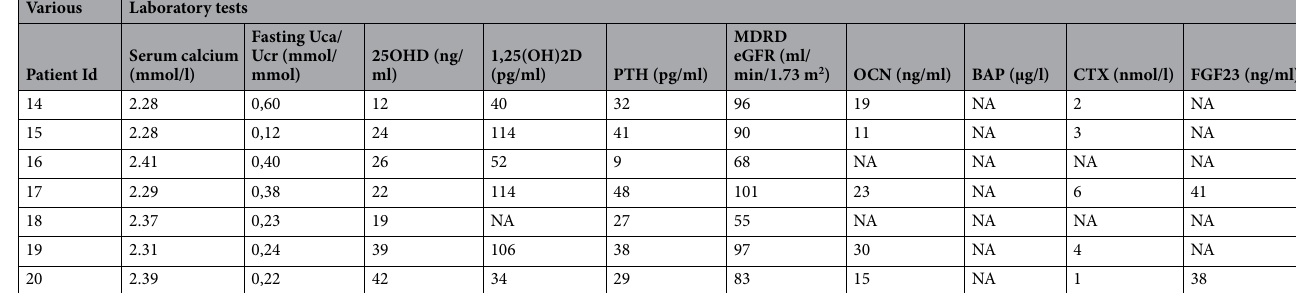
Table 1. Phenotypic characteristics of patients with SLC34A3 variants. a Unlike the other patients, the lowering of the TmPO4/GFR was inconsistent. TmPO4/GFR ratio of maximum rate of renal tubular reabsorption of phosphate to glomerular filtration rate, TRP tubular reabsorption of phosphate. Normal values: 1.3–1.85 mmol/l in adolescents, 0.85–1.5 mmol/l in adults for Serum phosphate; ≥ 0.7 mmol/l GFR for TmPO4/GFR; ≥ 80% for TRP. Uca urinary calcium, Ucr urinary creatinine, 25OHD calcidiol, 1,25(OH)2D calcitriol, PTH parathyroid hormone, FGF23 fibroblast growth factor 23, MDRD modification of diet in renal disease, eGFR estimated glomerular filtration rate, OCN Osteocalcin, BAP Bone-specific alkaline phosphatase, CTX C-terminal telopeptide of type I collagen, FGF23 Fibroblast Growth Factor 23. Normal values: 2.25– 2.6 mmol/l for Serum calcium; < 0.55 mmol/mmol Fasting for Uca/Ucr; 30–80 ng/ml for 25OHD; 20–120 pg/ ml in adolescents, 15–60 pg/ml in adults for 1,25(OH)2D; 10–65 pg/ml for PTH; ≥ 60 ml/min/1.73 m 2 for MDRD eGFR; 16–90 ng/ml in tanner 5 adolescent females, 26.6–51 ng/ml in 20–30 y/o females, 14.4–31.7 ng/ ml in > 30 y/o females, 27.9–60 ng/ml in 20–30 y/o males, 21.6–38.3 ng/ml in 30–55 y/o males, 15–35.6 ng/ ml in > 55 y/o males for OCN; 2.9–14.5 µg/l in premenopausal females for BAP; 0.96–4.8 nmol/l in 20–35 y/o females, 0.87–3 nmol/l in > 35 y/o females, 0.65–5.26 nmol/l in males for CTX; 23–95 ng/ml for